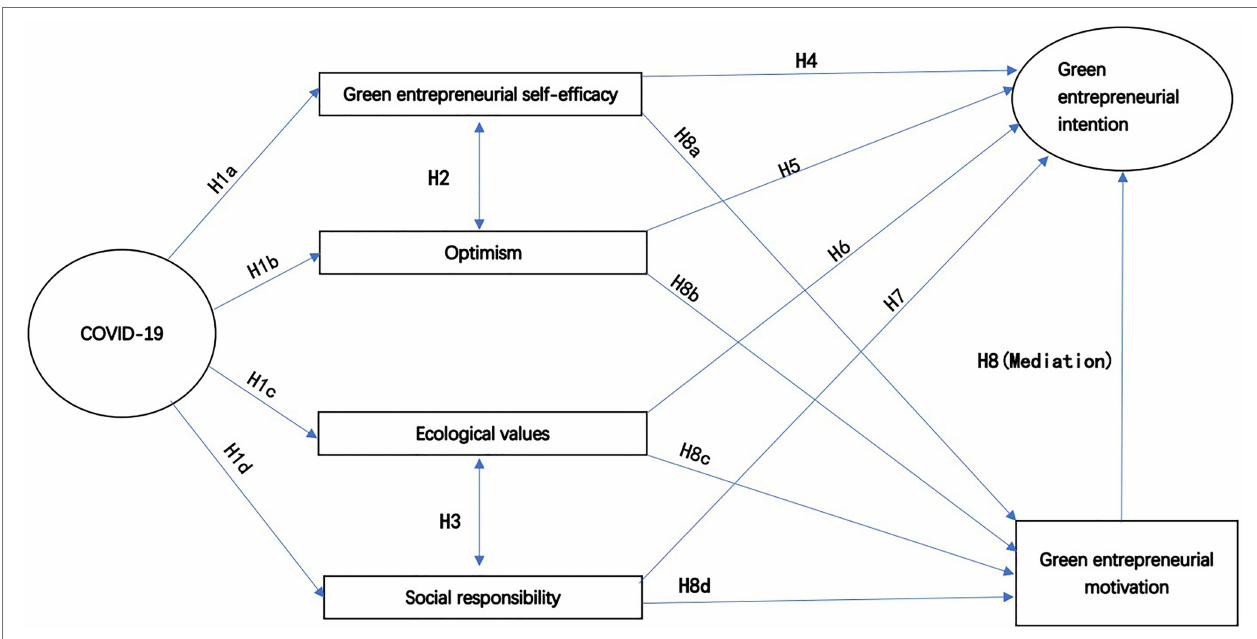
FIGURE 2 | Research